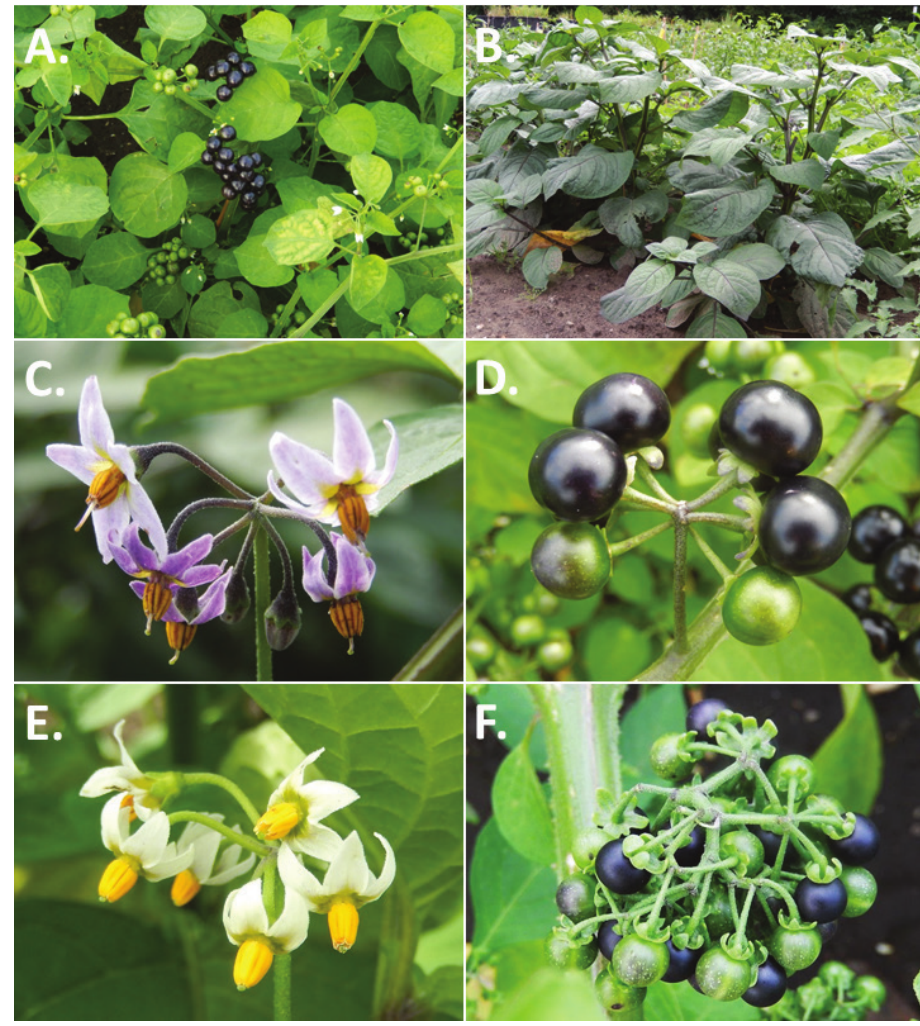
Figure 49. Solanum scabrum Mill. A Common habit B habit in taller varieties C flowers of the larger berried variety at full anthesis D fruits of a larger berried variety E flowers of the smaller berried variety at full anthesis F Fruits of a smaller berried variety ( A Nijmegen accession BG13 B Nijmegen accession A34750072 C Nijmegen accession GB22 D Nijmegen accession H065 E Nijmegen accession A34750067 F Nijmegen accession 2010/3). Photos by S. Knapp (previously published in “PhytoKeys 106”). pores lengthening to slits with age and drying, the connective often becoming brown- ish black in dry specimens. Ovary rounded, glabrous; style 2.5–5 mm long, densely pubescent with simple uniseriate trichomes 0.2–0.5 mm long in the basal 1/2 where included in the anther cone, exserted 0–1.5 mm beyond the anther cone; stigma capi- tate, the surface minutely papillate. Fruit a globose to slightly flattened berry, 10–20 mm in diameter, purplish black at maturity, opaque, the pericarp thick, shiny; fruiting pedicels 7–15(20) mm long, 0.5–1 mm in diameter at the base, 1.1–1.5 mm in